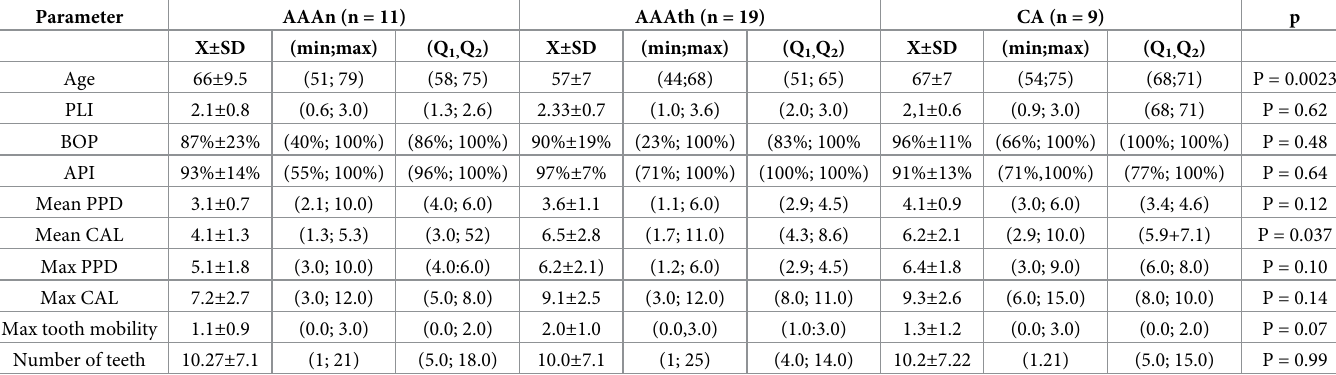
Table 5. The differences in periodontal status in subgroups AAAn, AAAth, and